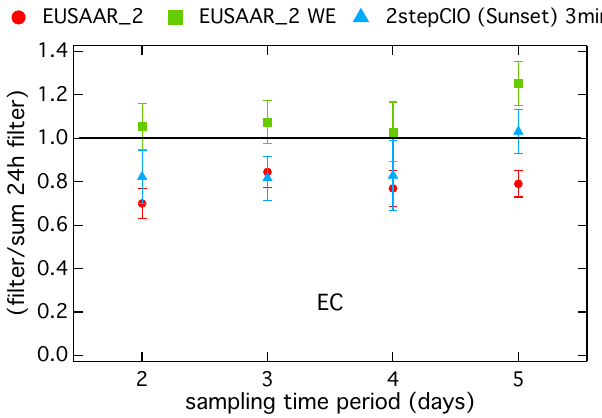
Figure 3. Ratio of the EC concentration on long-term filter samples to the sum of the EC concentration on the corresponding 24-h filter samples in dependence of the sampling duration in days determined with the EUSAAR_2 protocol on untreated (EUSAAR_2) and water-extracted (EUSAAR_2 WE) filter and for the 2stepCIO protocol on the Sunset (2stepCIO (Sunset) 3